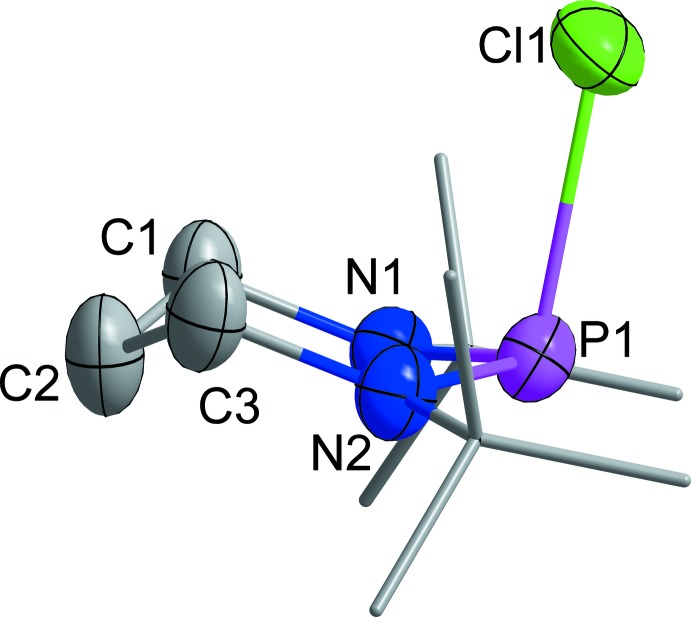
Chair conformation of the mol­ecule (H atoms are omitted for clarity); note the cyclo­hexane-like conformation at the ‘carbon-atom side’ [folding angle 53.07 (15)° as compared to 54.5 (6)° in the ordered, monoclinic phase of C6H12 (Kahn et al., 1973 ▸)] and the ‘semi-flattened’ conformation [folding angle 27.96 (7)°] at the ‘phospho­rus/nitro­gen-atom side’.